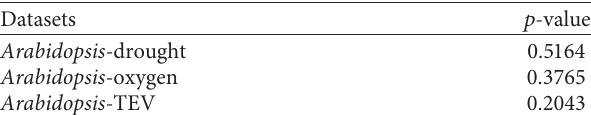
Table 4: Average p -value of selected